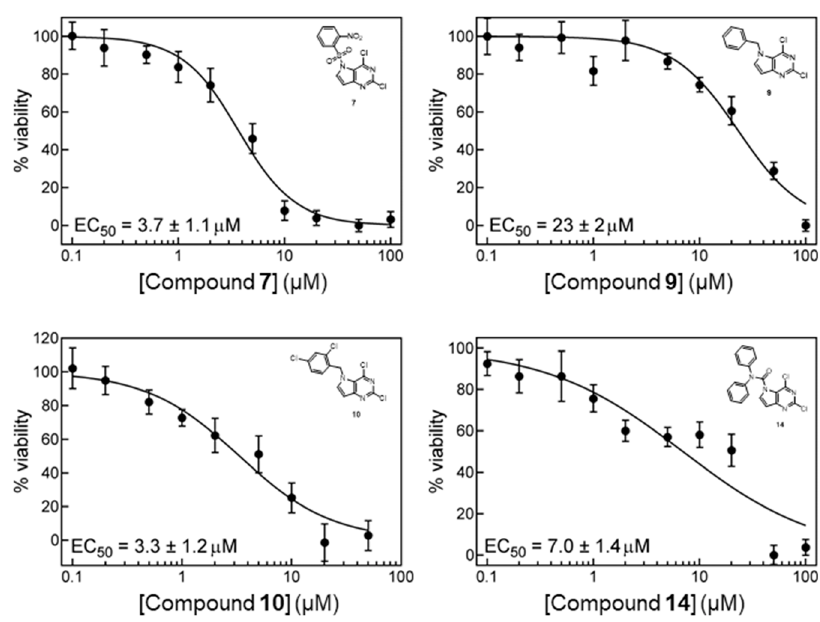
Figure 4. CCRF-CEM MTT assay results.